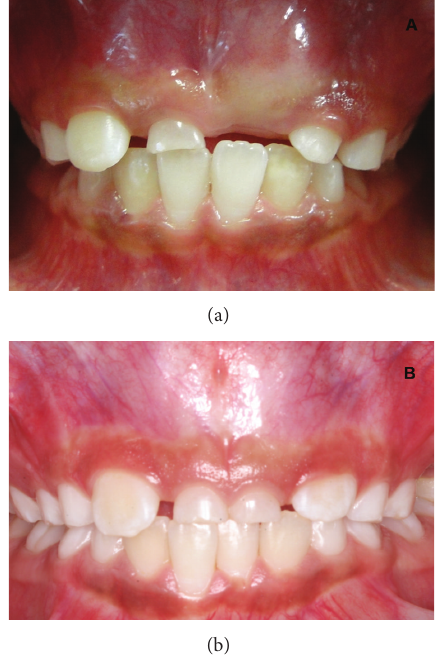
Figure 1: Initial intraoral view showing the absence of the perma- nent maxillary central incisors in both